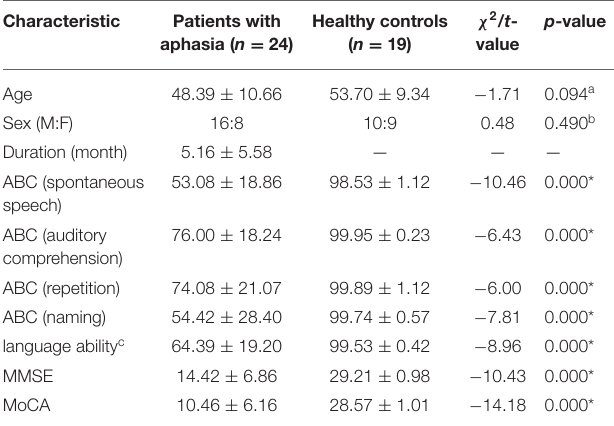
TABLE 1 | Demographic and clinical data comparisons between the patients with aphasia and healthy controls. Characteristic Patients with Healthy controls aphasia ( n = 24) ( n =